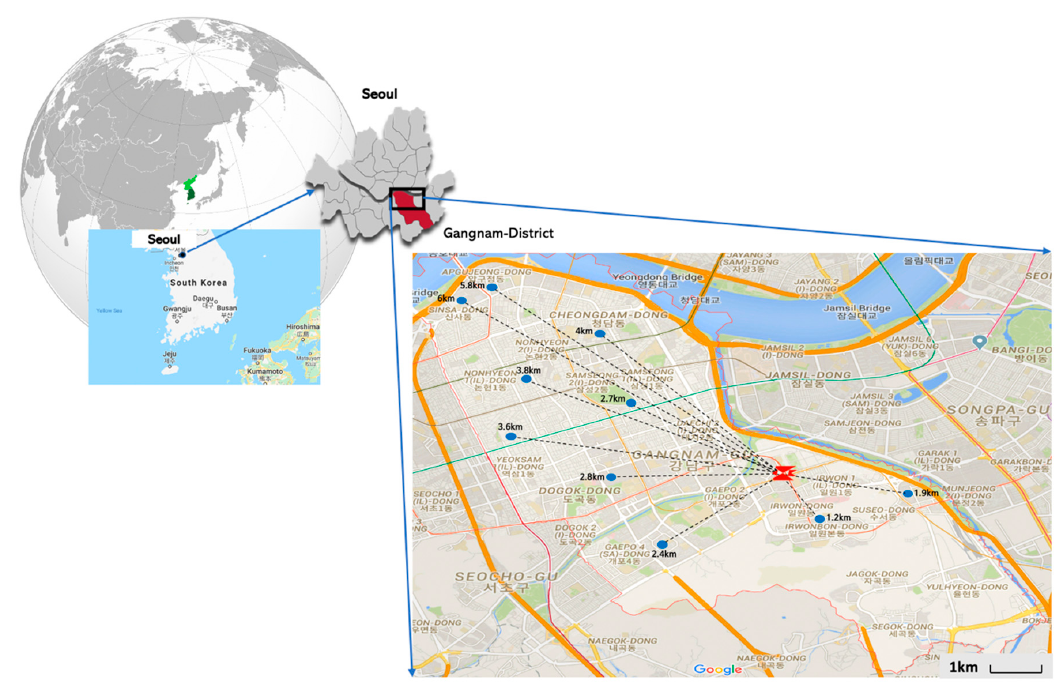
Figure 6. Experimental delivery network in the Gangnam district of Seoul